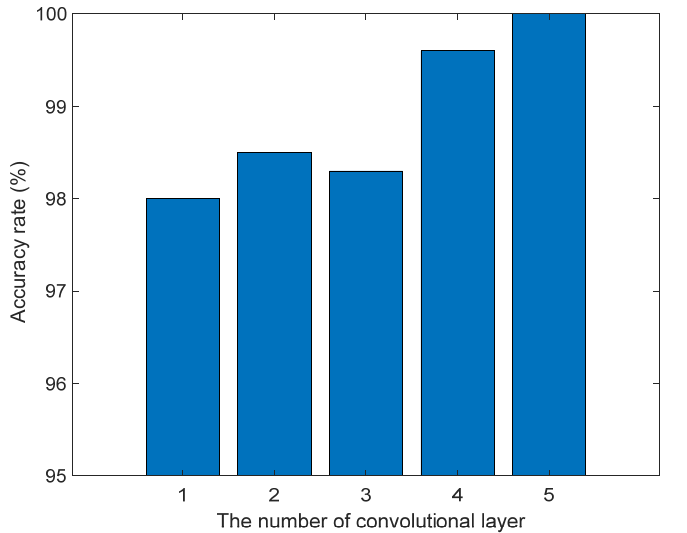
Figure 4. The relationship between the accuracy rate and the number of various convolution layers.